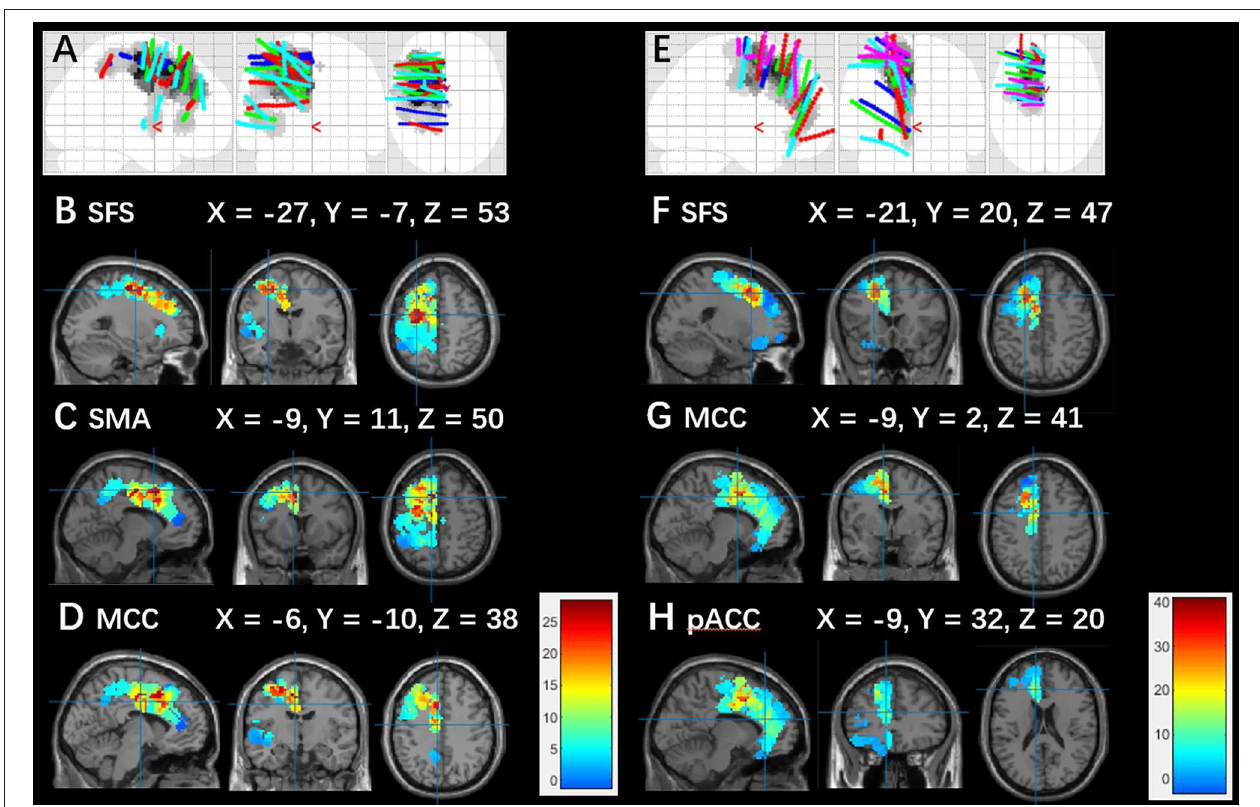
FIGURE 4 | Electrodes position map and averaged epileptogenicity map. (A) Blue, green, red, and cyan dots show actual SEEG recording contacts from cases 1, 2, 3, and 4 in group 1. (B–D) EM averaged over the patients in group 1. (E) Blue, green, red, cyan, and pink dots indicate actual SEEG recording contacts from cases 10, 11, 12, 13, and 15 in group 2. (F–H) EM averaged over the patients in group 2. The significance map calculated based on the power of high frequencies at seizure onset was corrected by FWE ( p < 0.05). The color scale indicates T scores. Electrodes and maps are drawn over the MNI152 atlas. Note that the epileptogenicity maps in patients with right-sided lesions are all horizontally flipped to the left side.